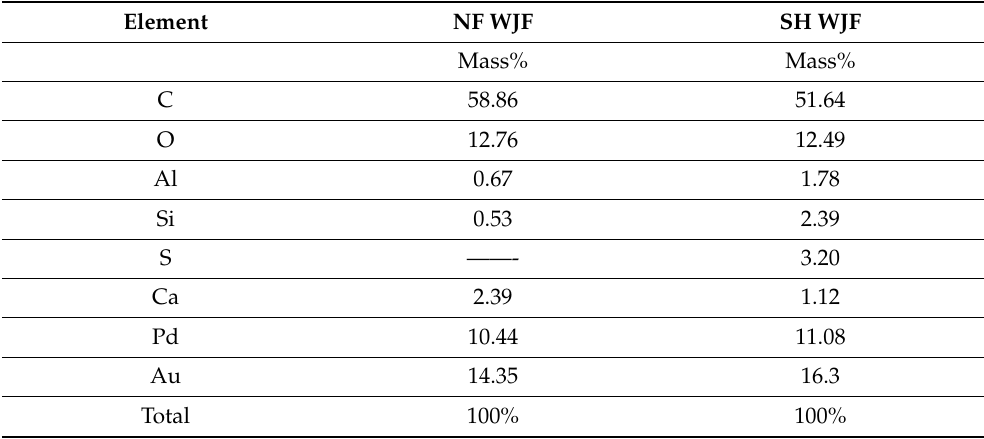
Table 2. Comparison of the results of the EDS semi-quantitative analysis of: (a) NF WJF and (b) SH WJF.